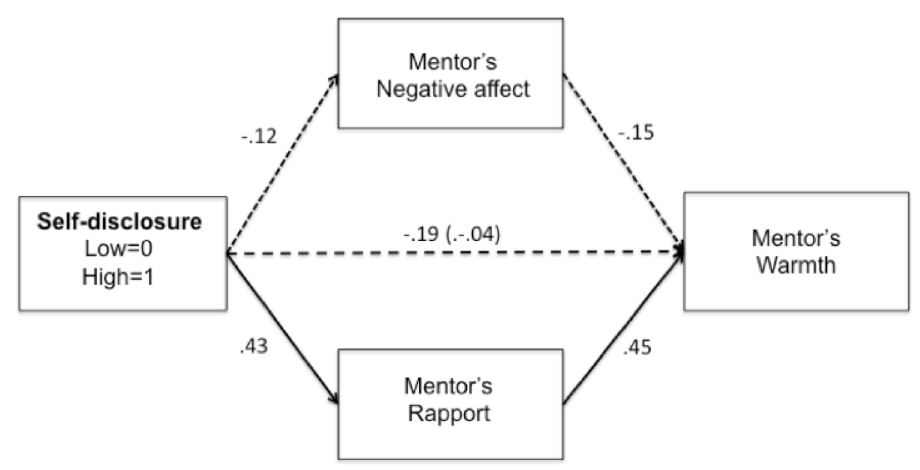
Fig 2. Direct and indirect effects predicting feedback warmth. Solid lines represent significant simple paths. Dotted lines represent nonsignificant simple paths. Parenthetical value indicates total effect. Coefficients are unstandardized.